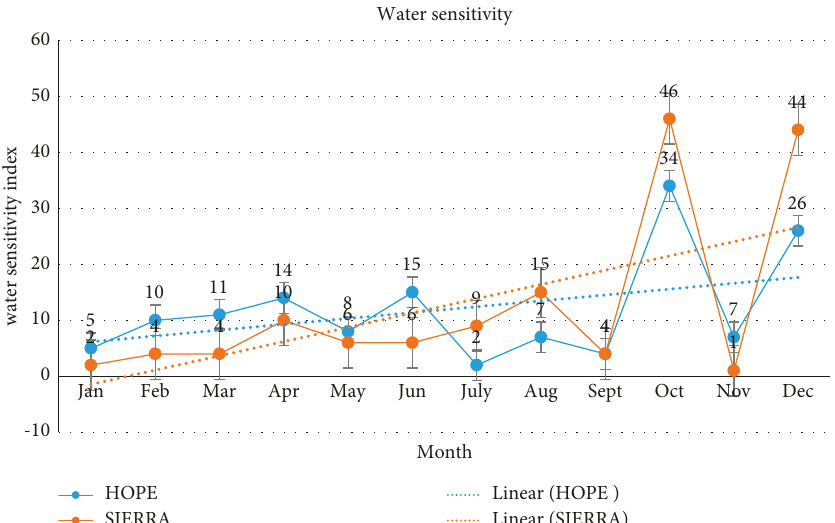
Figure 4: Comparison of water sensitivity trends for Hope and Sierra malting barley varieties over the 12-month storage period.